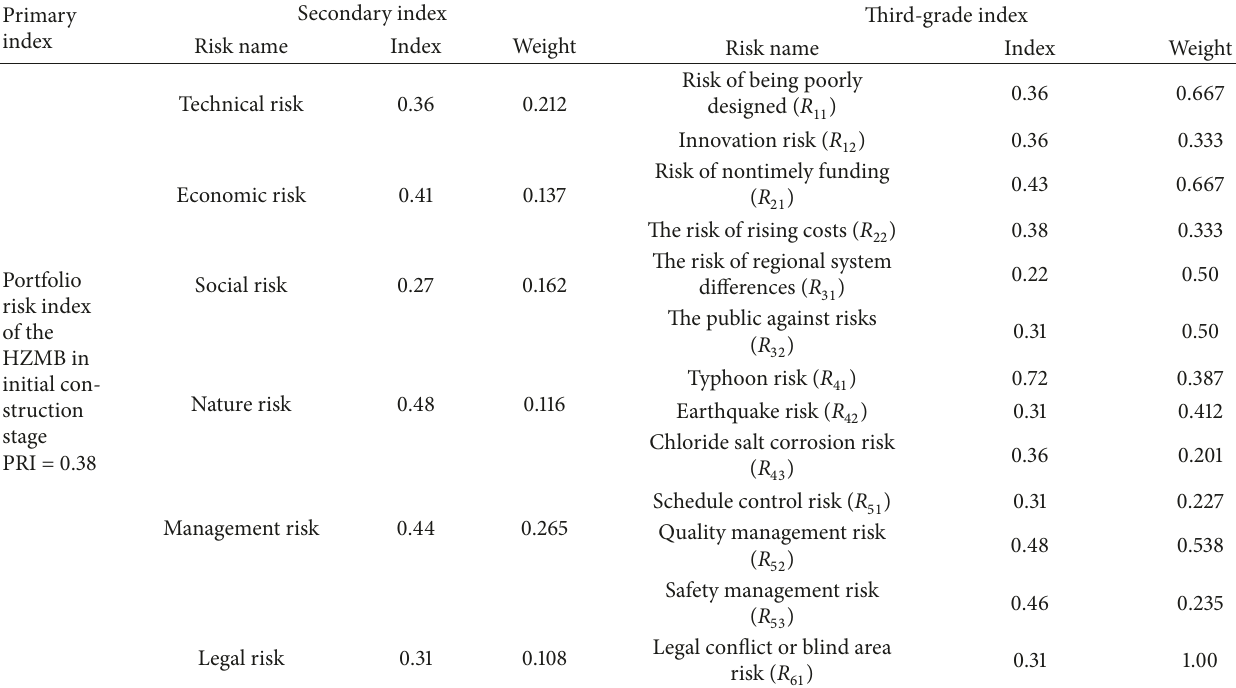
Table 10: The classification and portfolio risk index of the HZMB in initial construction